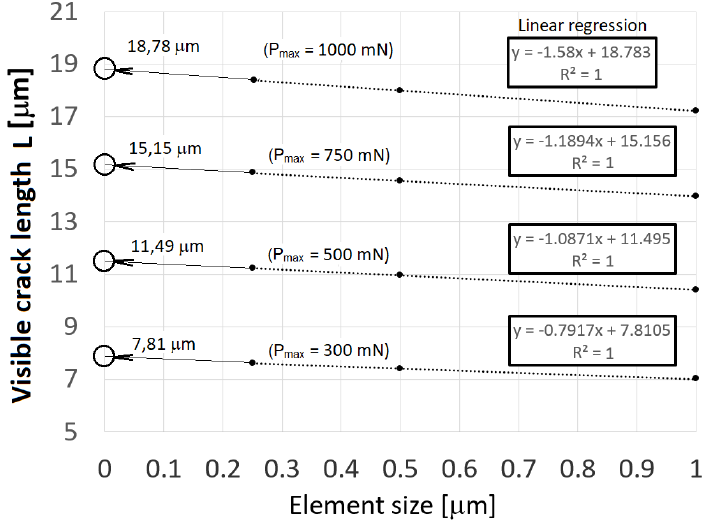
Figure 11. Size effect of mesh density on crack length.